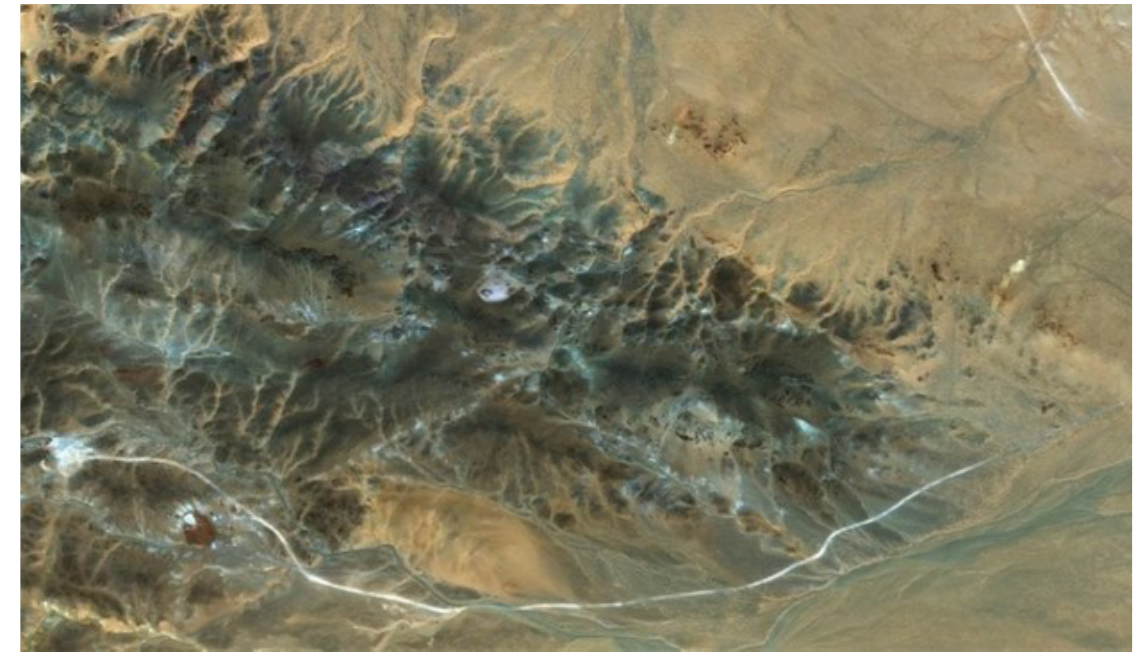
Fig. 1. Satellite image of the Sharga hill survey area on the Google Earth Map, 2019 UTM coordinates planimetric data for topographic map scale with 1:1000, values are shown in following Table 1.